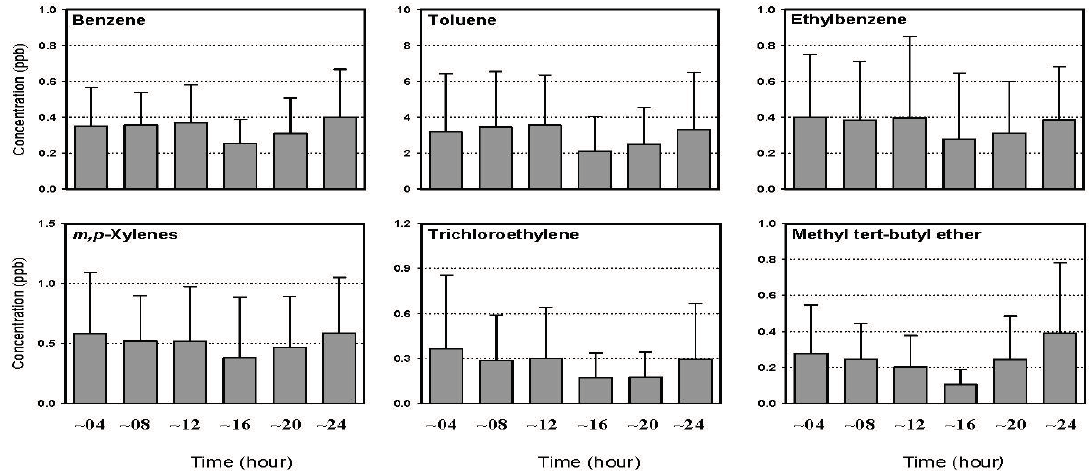
Figure 6. Diurnal variations of the 4 hourly average concentrations of selected VOCs at industrial site II during the 2010/2011 campaign (the error bar indicates a standard